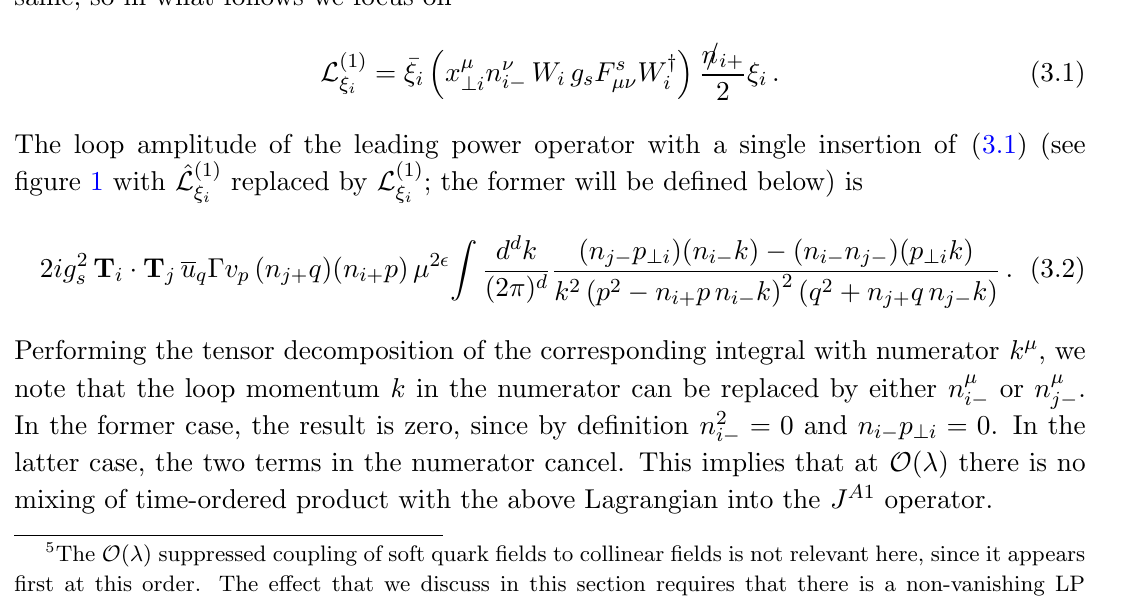
Figure 1 . Soft loop with a single insertion of the sub-leading power Lagrangian ^ rise to mixing of the time-ordered product J T 1 into J A 1 . The three lines on the left symbolize possible further collinear directions, not present in our